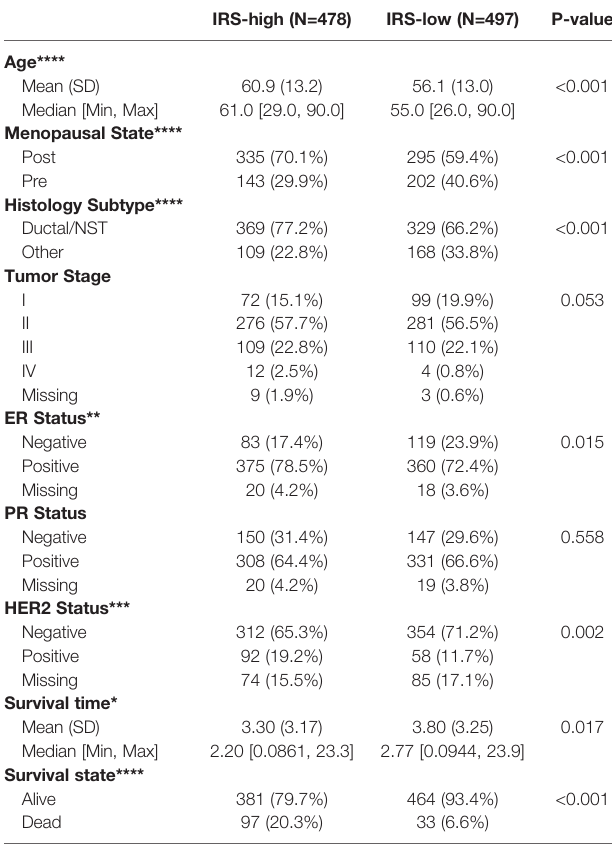
TABLE 1 | The association between IRS and pathological